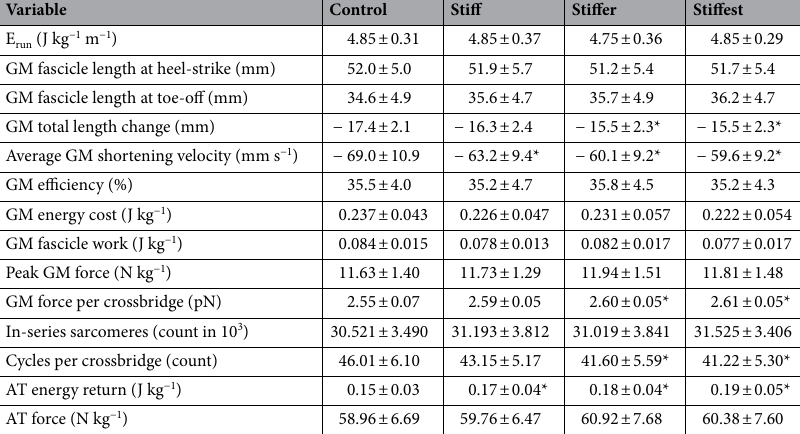
Table 1. Measured dynamics and modelled energetics (mean ± SD; n = 14) for the gastrocnemius medialis (GM) muscle and Achilles tendon (AT). *Significant ( p ≤ 0.017) differences compared to Control.